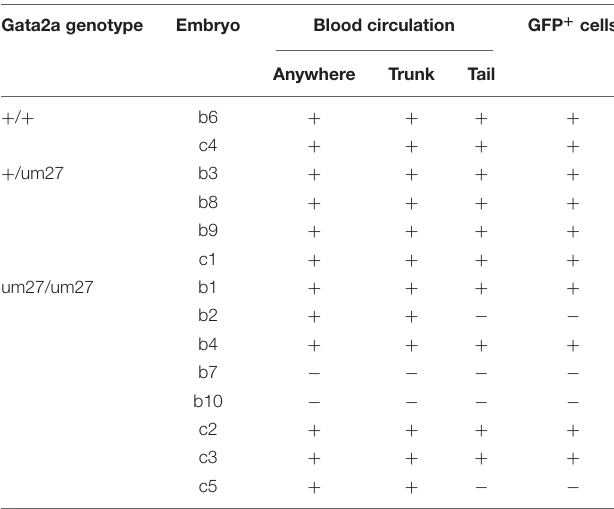
TABLE 2 | Blood circulation in Gata2a mutants. Gata2a